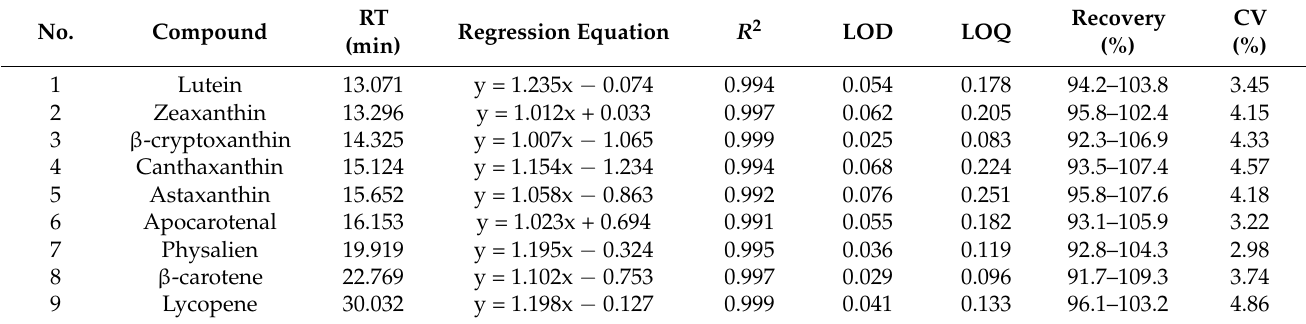
Table 2. Parameters of method validation for carotenoids 1 .